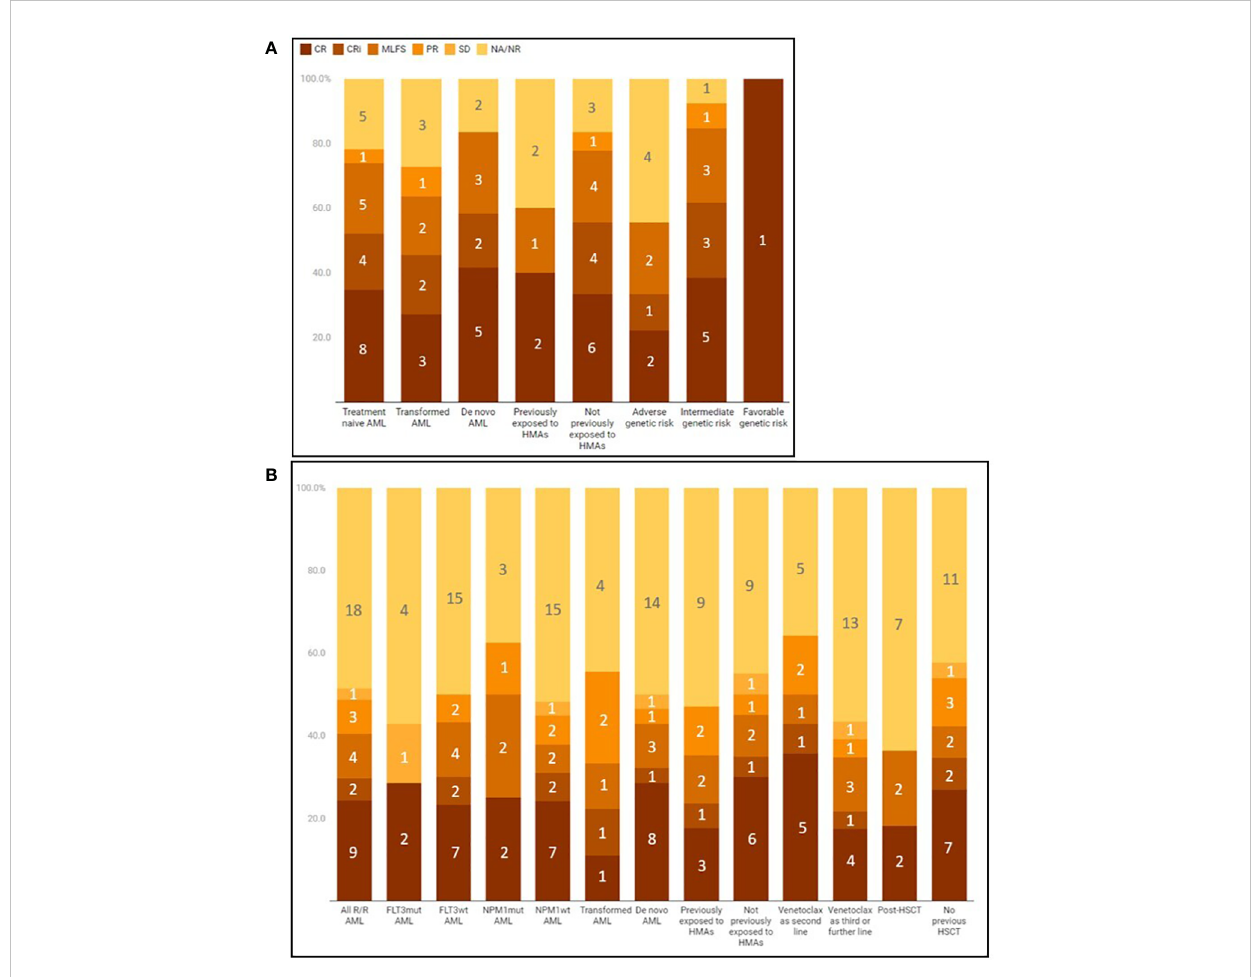
FIGURE 1 Best response to venetoclax combinations in different subgroups of treatment-naïve (A) or relapsed/refractory (B) AML. Responders can be visualized as a percentage of the subgroup (vertical axis) or as raw counts (numbers inside the bar graph boxes). CR, complete remission; CRI, complete remission with incomplete hematological recovery; HMAS, hypomethylating agents; MLFS, Morphological Leukemia Free State; NA, not available due to patient's death before evaluation; NR, non-responder, PR, partial response; SD, stable disease; VEN,